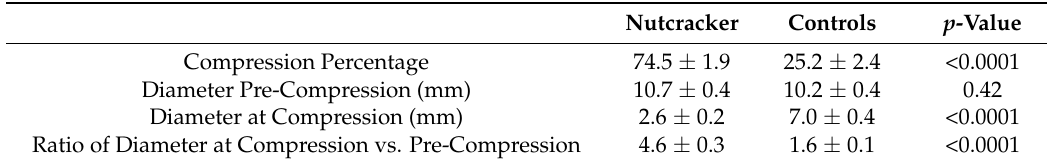
Table 2. Left renal vein compression imaging